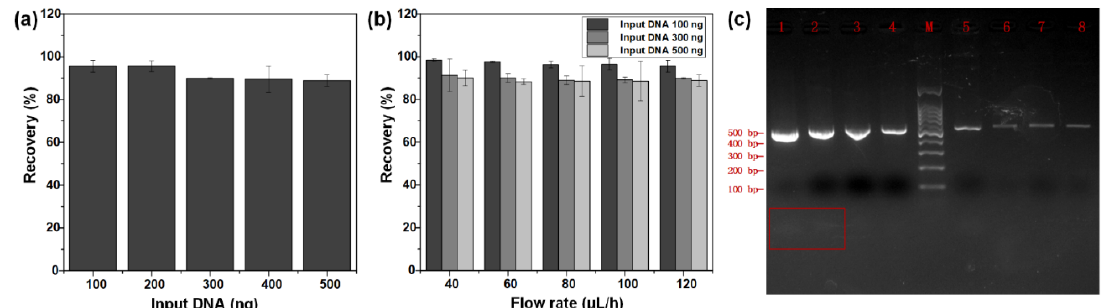
Figure 5. ( a ) The DNA recovery e ffi ciency with input from 100 ng to 500 ng at the fluid velocity of 120 µ L / h with a NdFeB magnet at position 3. ( b ) The trend of DNA recovery e ffi ciency with the u fl from 40 µ L / h to 120 µ L / h, with DNA input of 100 ng, 300 ng, and 500 ng. ( c ) 2% agarose gel electrophoresis image of PCR product and purified product. Lane 1 and lane 2, 507 bp PCR product; line 3 and line 4, product purified in the tube; line 5-8, product purified on the chip with the u fl from 40 µ L / h to 100 µ L / h; line M: 100 bp DNA Ladder. Red box: di ff used bands (extra primers). Table 1. The A260 / A280 ratio and A260 / A230 ratio show the purification results of PCR product. The u fl is 100 µ L / h and DNA input is 100 ng when purifying DNA on chip. Sample 260/280 260/230 507 bp DNA purified in tube